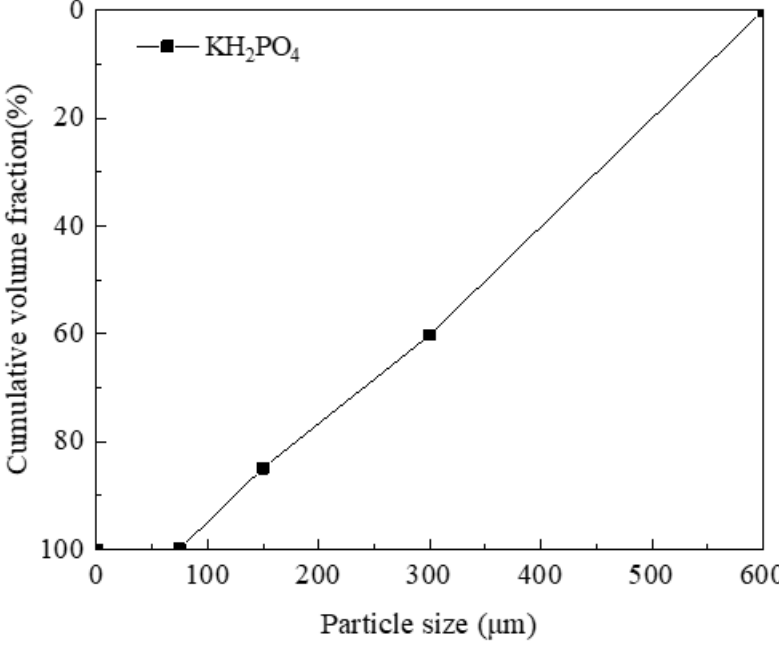
Figure 2. Particle size distribution of KH 2 PO 4 .